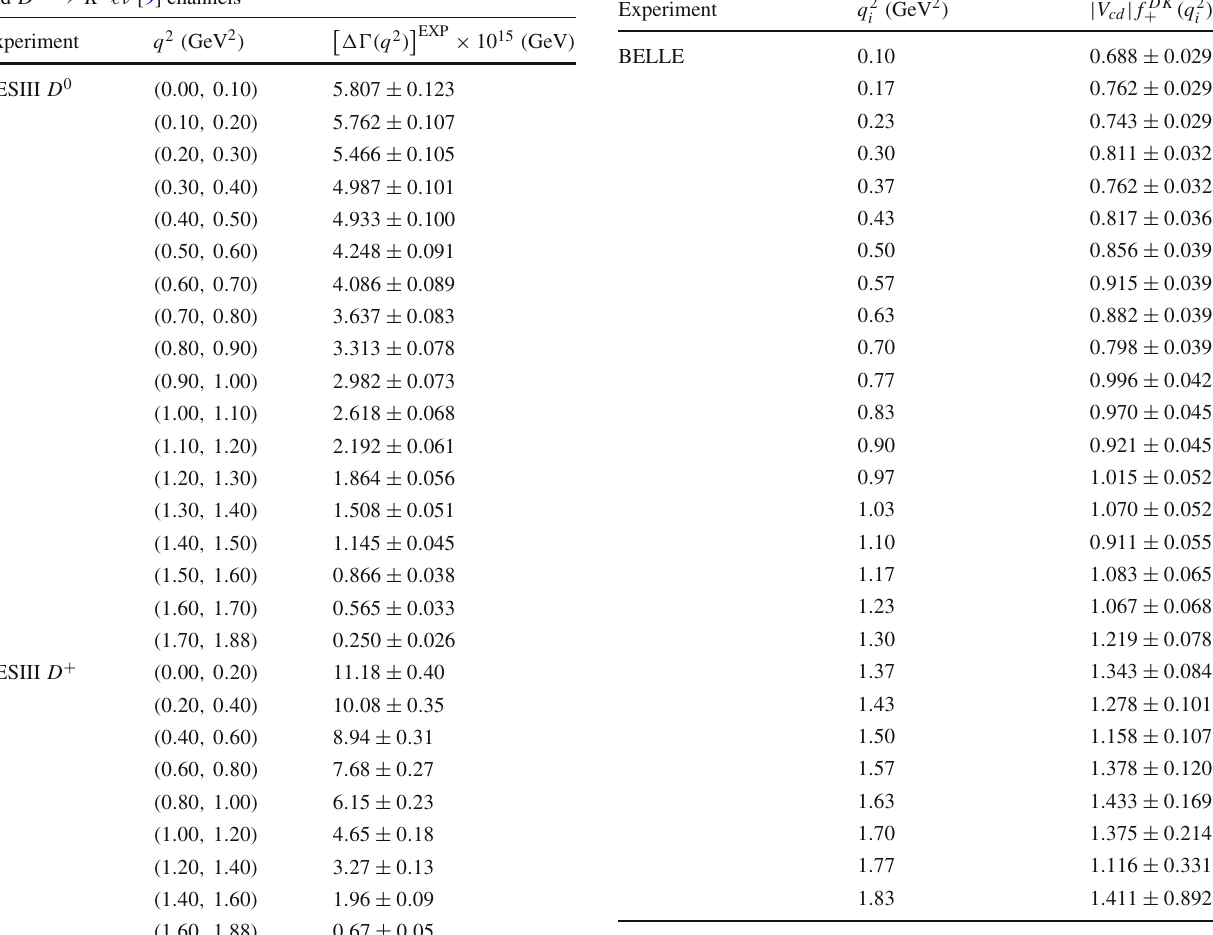
Table 6 Values of the partial decay rates transition in the q 2 -bins measured by BESIII for the D 0 → K − (cid:3)ν [8] and D + → K 0 (cid:3)ν [9] channels